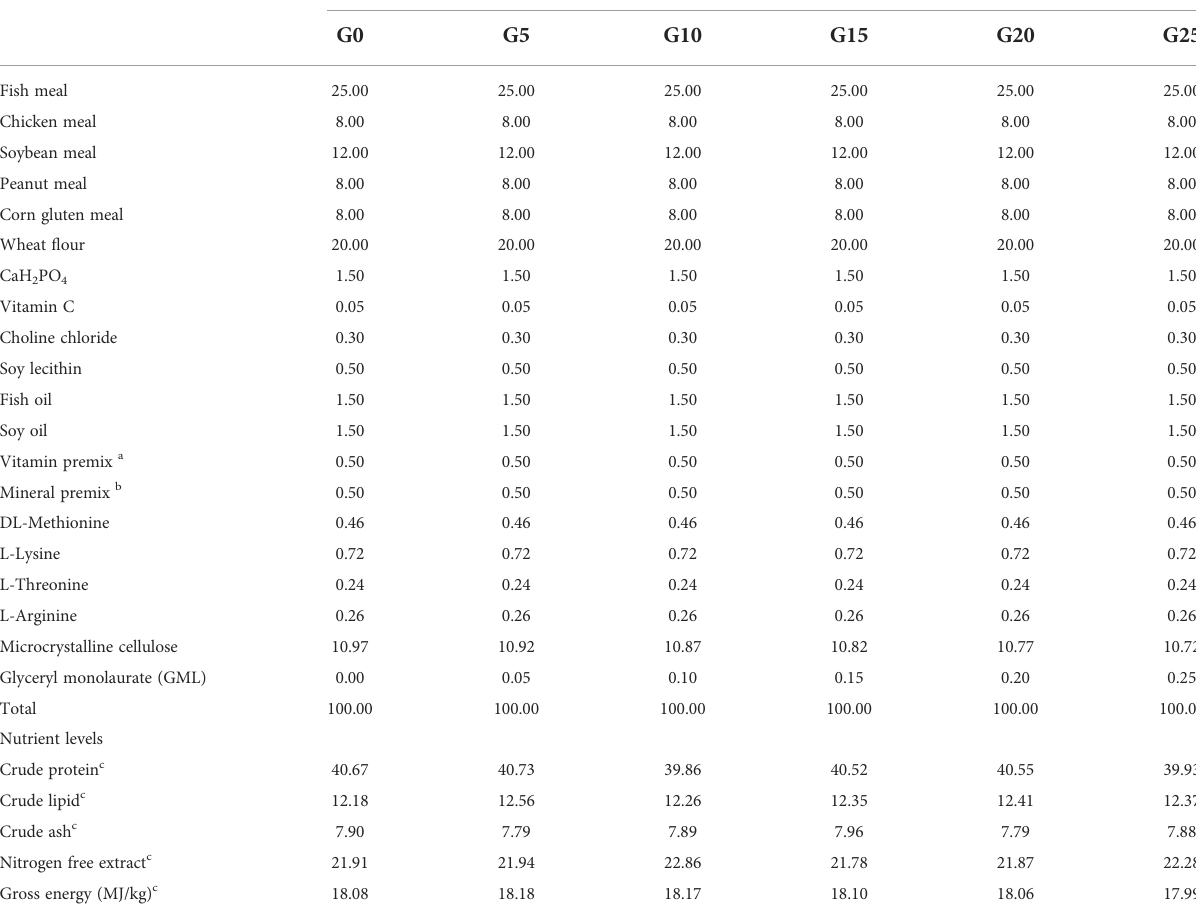
TABLE 1 Composition and nutrient levels of the experimental diets (dry matter basis, %).